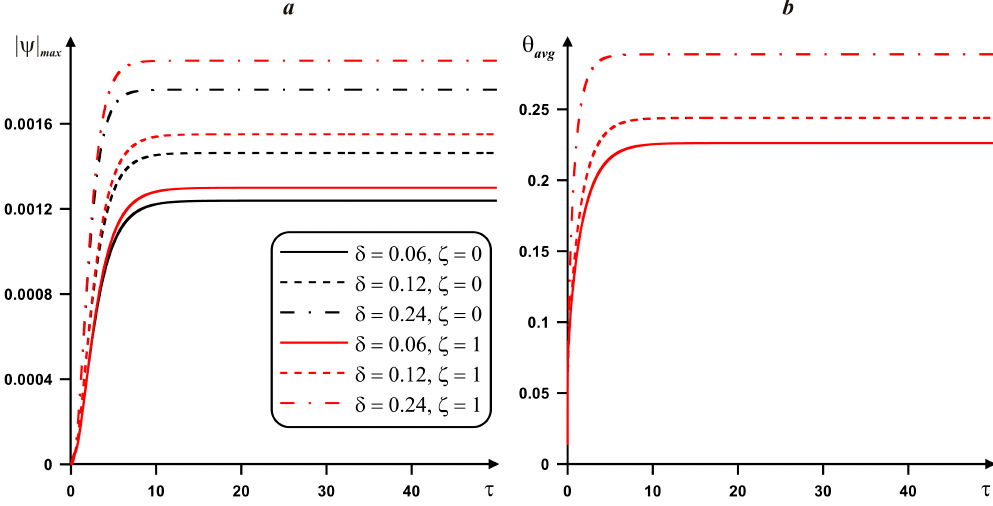
Figure 5. Variations of fluid flow rate and average heater temperature for h 1 = 0.15 and different values of ζ and fins thickness: ( a ) fluid flow rate; ( b ) average heater temperature.